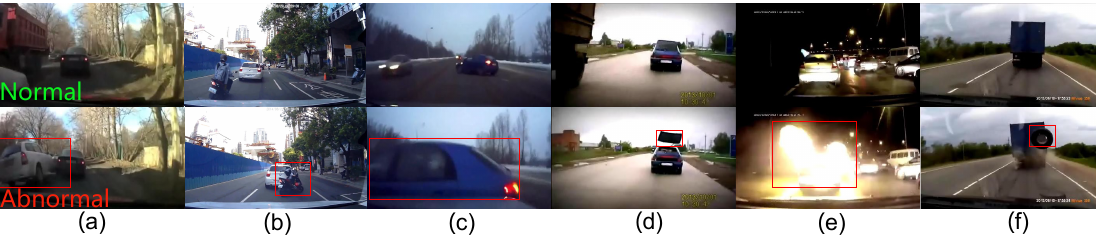
Figure 1. Typical driving anomalies of ( a ) vehicle-to-vehicle crash, ( b ) motorbike-to-vehicle crash, ( c ) vehicle crossing, ( d ) vehicle roof throwing, ( e ) vehicle catching fire, and ( f ) falling tire.